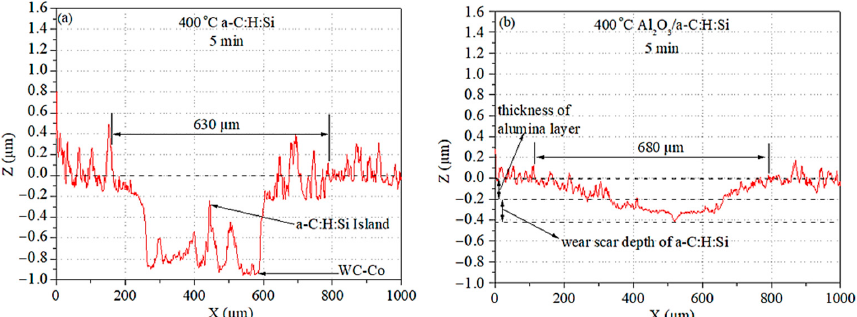
Figure 5. Wear scars line profiles taken on the ( a ) a-C:H:Si and ( b ) Al 2 O 3 /a-C:H:Si coatings after the 5 min sliding tests at 400 °C.